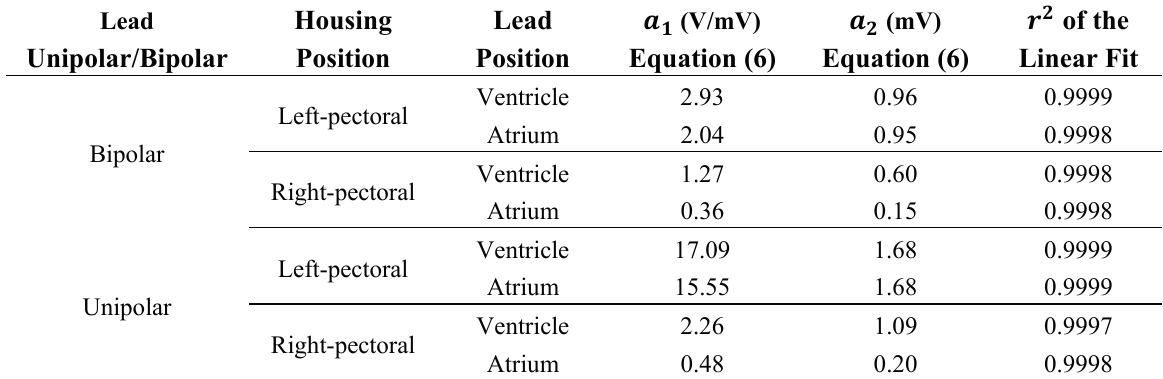
Figure 2. Results of the induced voltage for the homogenous exposure for ( a ) the bipolar lead, and ( b ) the unipolar lead. The linear fit to the measured values is indicated by the solid lines. The dashed lines indicate the extrapolation of the linear fit to the ranges where no induced voltages were measured due to the operation range of the used differential amplifier of the measurement system. Table 1. Results for the linear fit of the induced